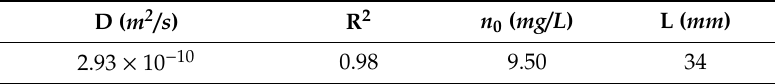
Table 2. Fitting result of inward diffusion coefficient.